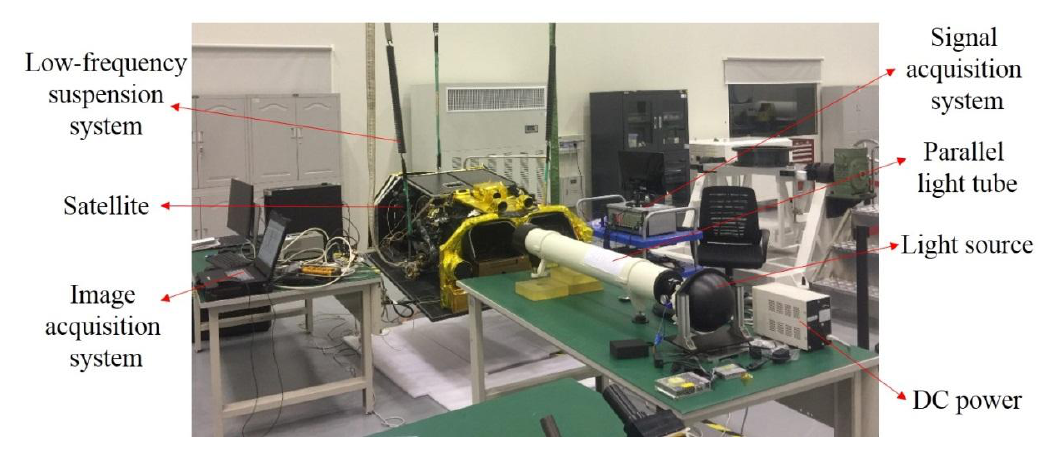
Figure 11. Image of the narrow line target taken by the camera.